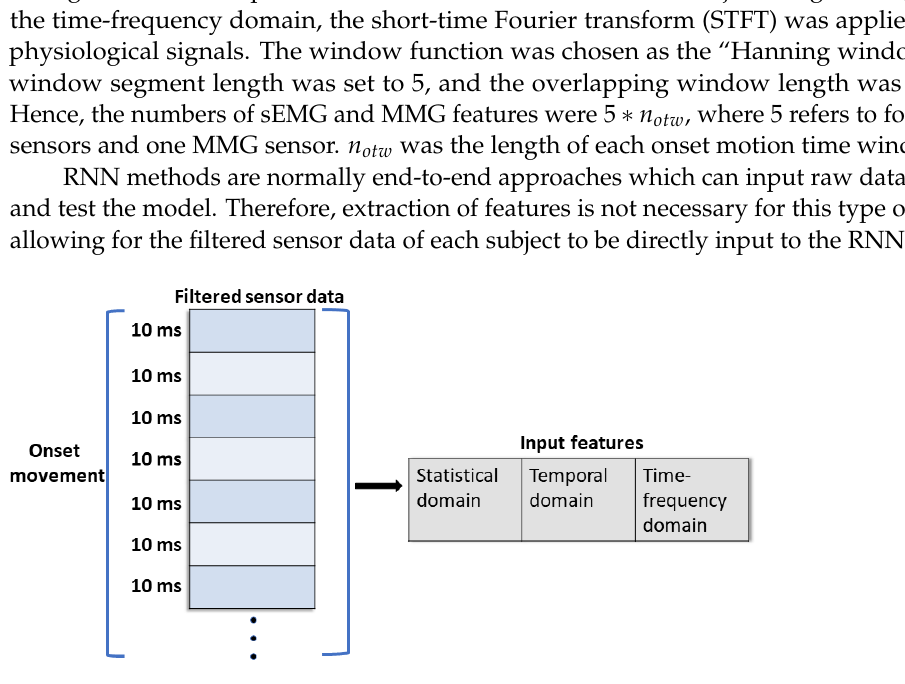
Figure 5. The input features are calculated within the whole time window of onset movement. The motion data of each subject can be reformed as a single